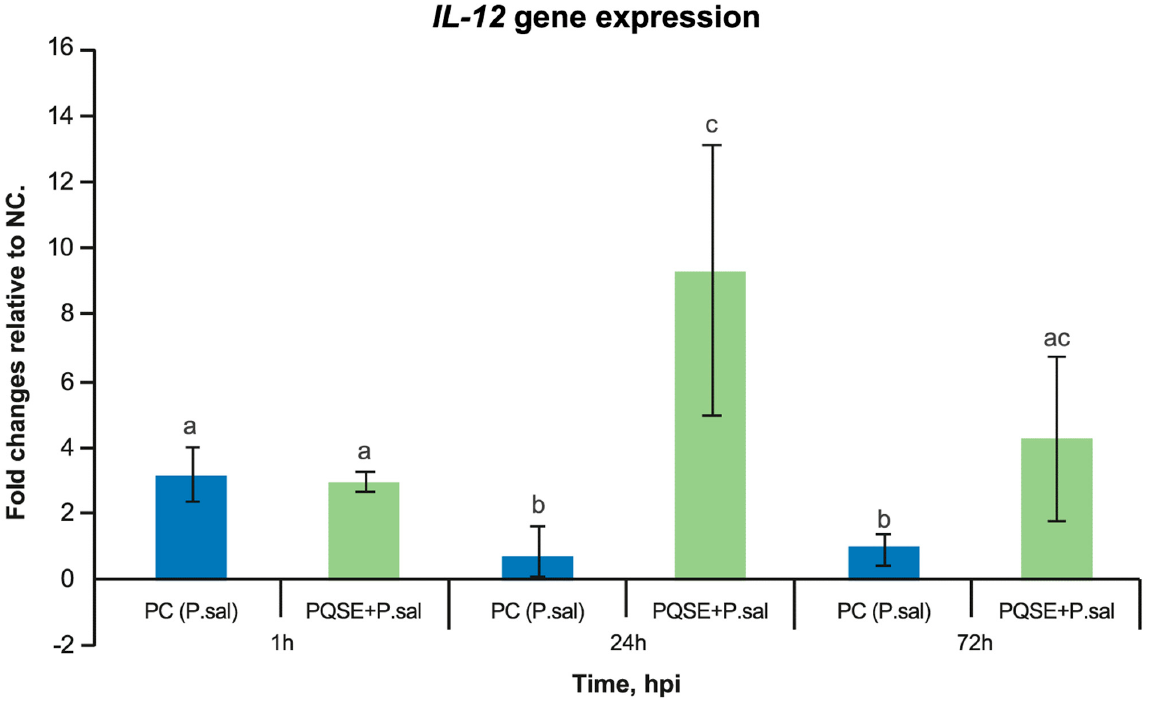
Figure 8. Gene expression analysis of IL-12 at 1, 24 and 72 hpi in SHK-1 cells pre-treated with 0.5 µ g/mL of PQSE. SHK-1 cells pre-treated for 4 h with PQSE, prior to a challenge with P. salmonis, significantly increased ( p < 0.05) the gene expres- sion of IL-12, with respect to NC and PC, at 24 and 72 hpi. The results are expressed as fold change relative to the NC, as average values of triplicate determinations. NC: Negative Control (without PQSE and without P. salmonis ); PC: Positive Control ( P. salmonis ); PQSE/P.sal: SHK-1 cells pre-treated with PQSE and challenged with P. salmonis. Different letters, a, b and c depict statistically significant differences according to the Mann-Whitney test ( p < 0.05). 3.7. Purified Quillaja Saponaria Extracts (PQSEs) Favor the Formation of Phago-Lysosomes in SHK-1 Cells This study confirmed that the “live” virulent strains of P. salmonis (vPs) have the abil- ity to significantly ( p < 0.05) reduce the degree of “phagosome conversion” and P-L fusion (only 9% of colocalizations), whereas formaldehyde-inactivated strains of P. salmonis (iPs) partially blocked phagosome maturation and P-L fusion, as shown in Figure 9, allowing for the maturation of some phagosomes and their binding to lysosomes (26%).